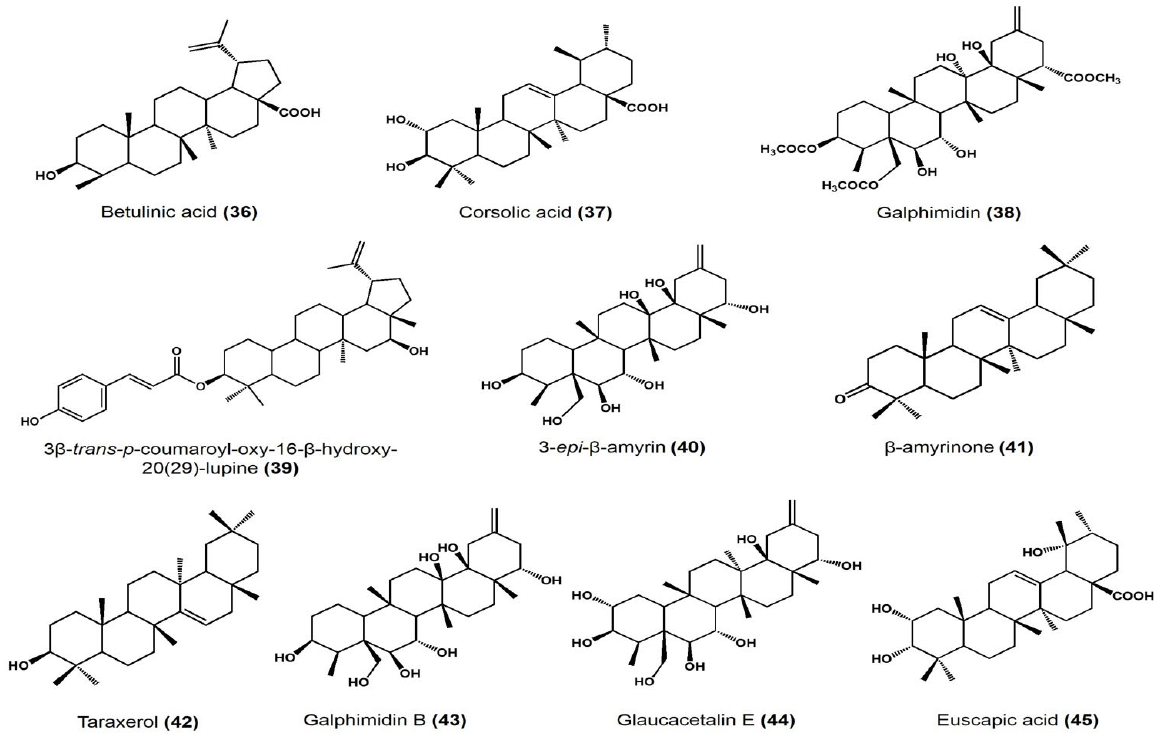
Figure 4. Chemical structures of PCTs identified in native Mexican plants.